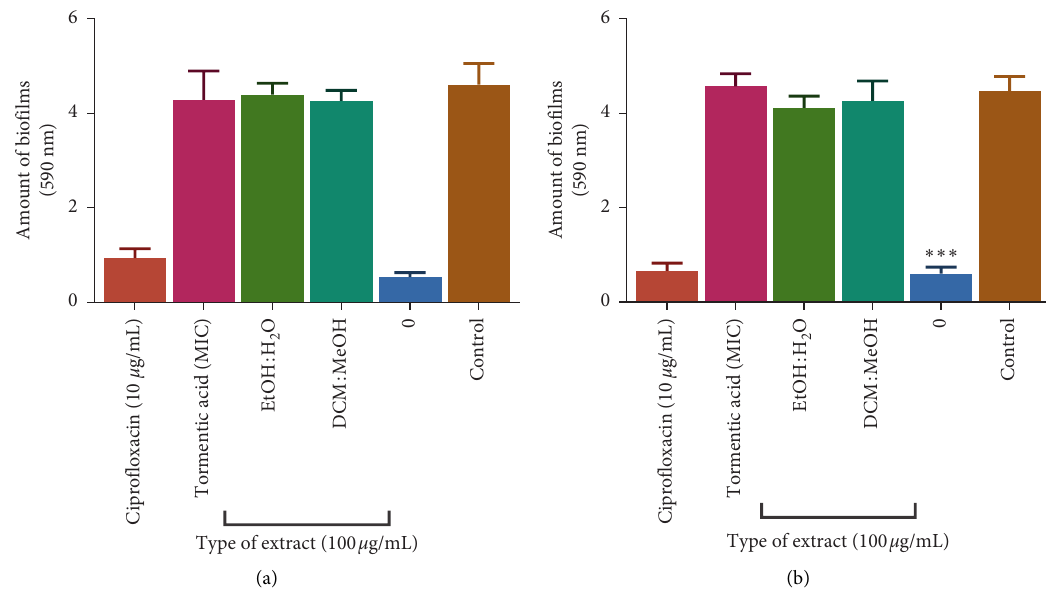
Figure 5: The effect of ciprofloxacin, tormentic acid congener, and C. viminalis extracts on S pyogenes (a) and A. baumannii (b) biofilm production, respectively. The bacterial strains were incubated together with the test agents for 72 hours, and the formed biofilm was quantified using 0.1% crystal violet. Ciprofloxacin inhibited the formation of biofilms in both bacteria, whilst tormentic acid congener and C. viminalis extracts showed no significant inhibitory effect. Asterisk denotes a significant difference ( ∗∗∗∗ P < 0.0001).